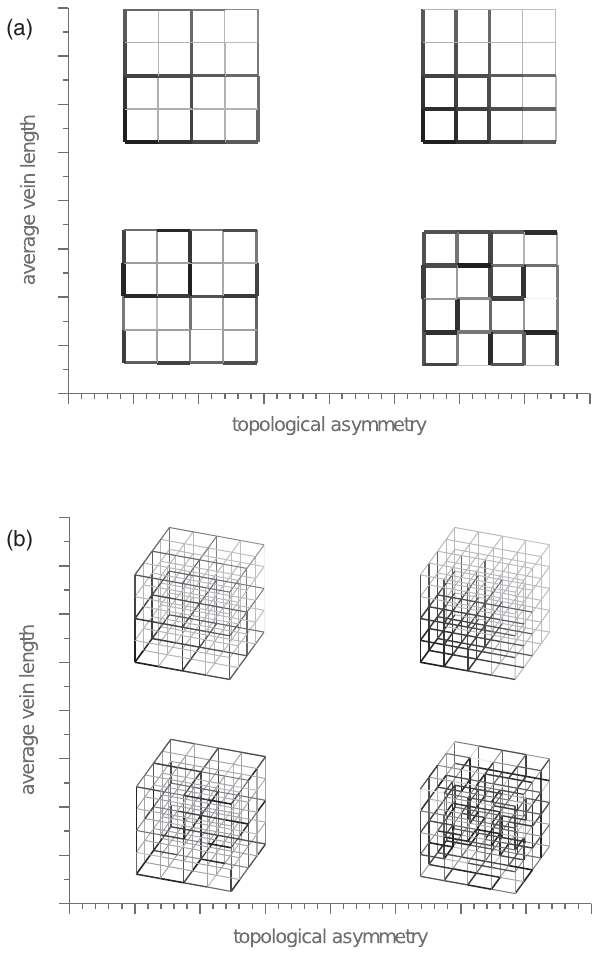
FIG. 7. Average vein length versus topological asymmetry for toy graphs in (a) 2D and (b)